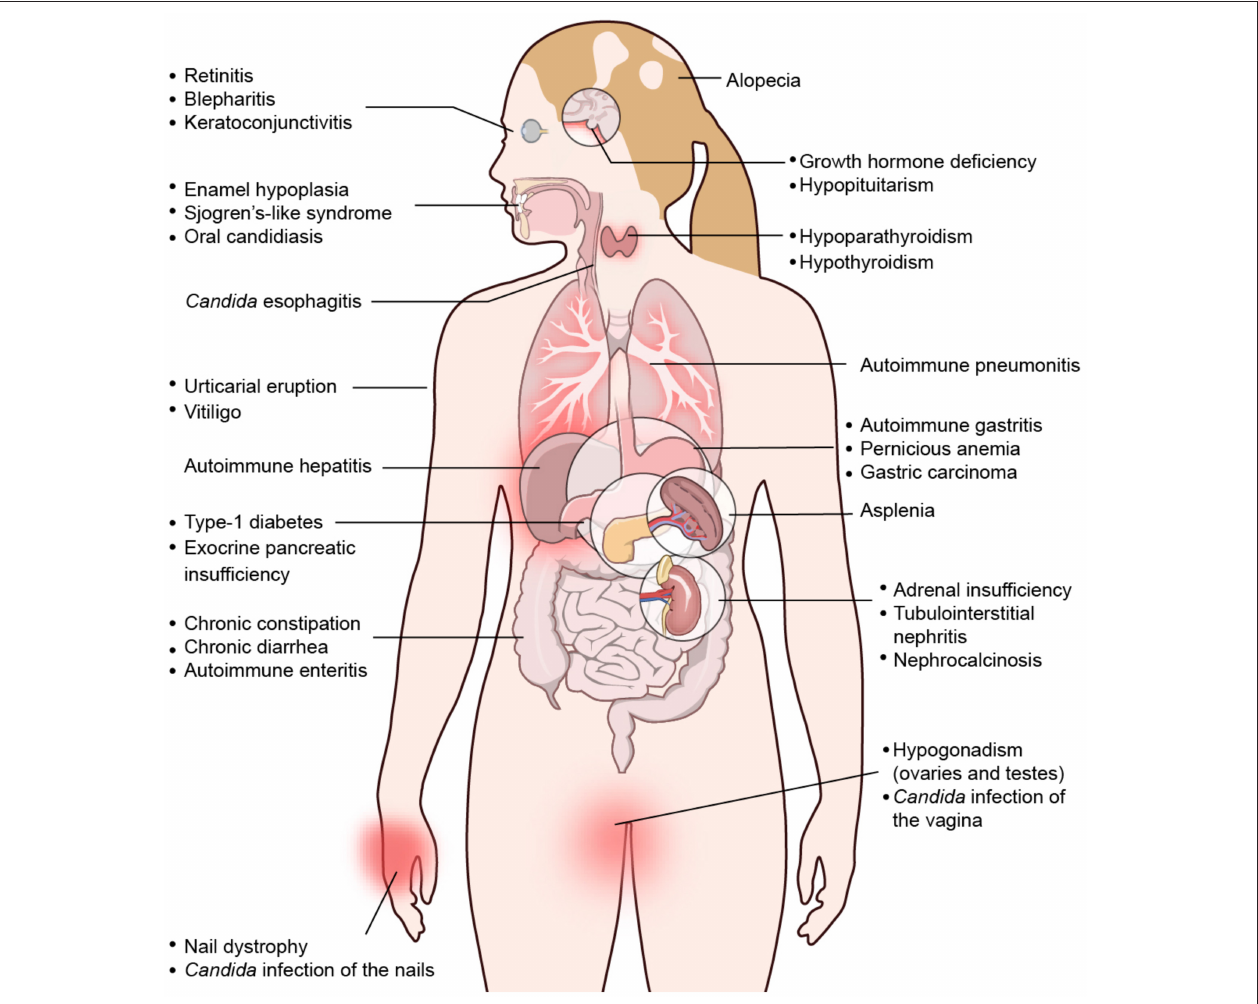
FIGURE 1 | Spectrum of clinical manifestations in APECED patients. Depiction of organ-specific autoimmune manifestations observed with variable frequencies in patients with APECED. Derived from Constantine and Lionakis (13) with permission from